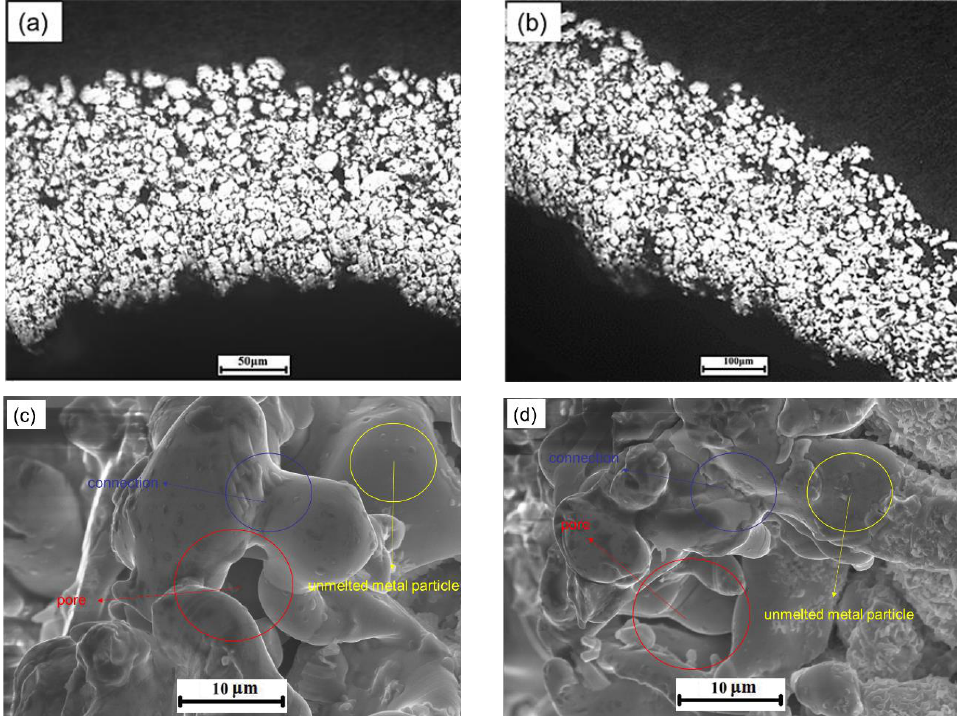
Figure 6. The wall micromorphology of the MHS with different diameters sintered at 1100 °C: ( a – c ) d = 3.28 mm; ( b – d ) d = 5.76 mm.